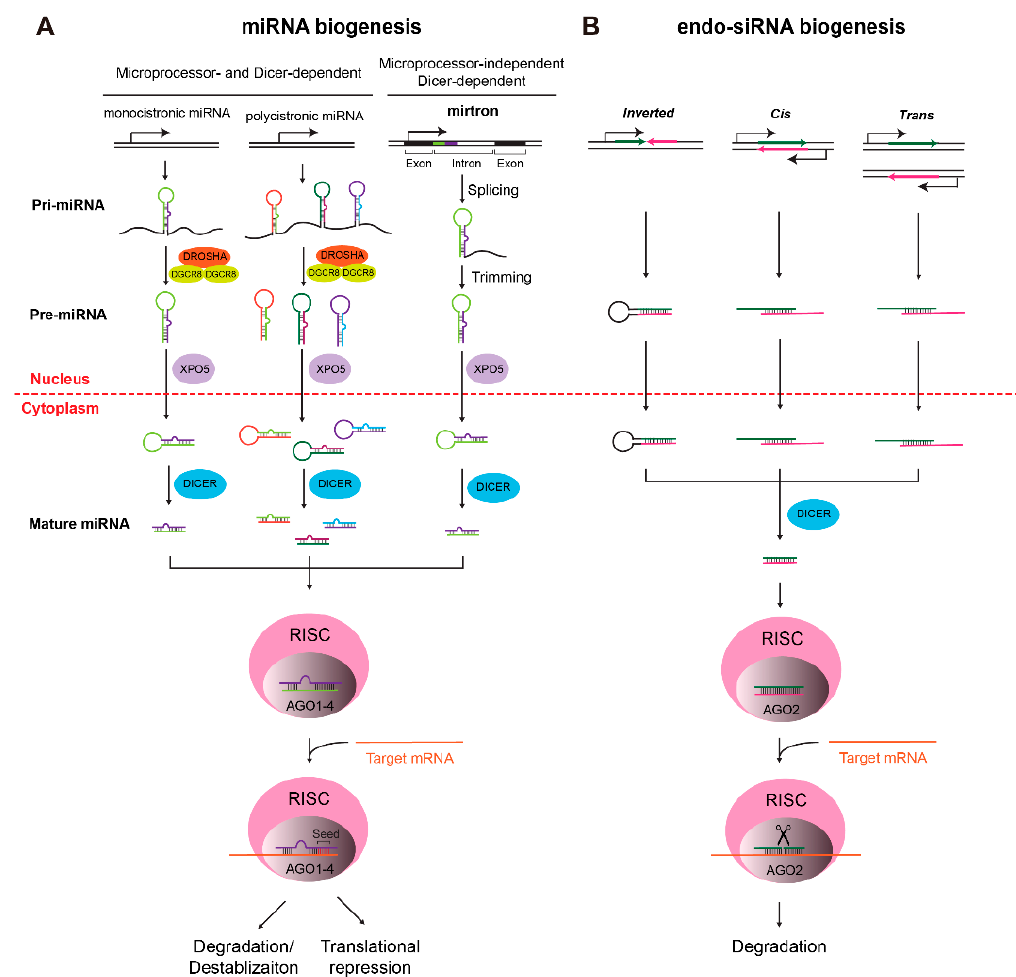
Figure 1: Dicer-dependent biogenesis of miRNAs ( A ) and endo-siRNAs ( B ). ( A ) Biogenesis of miRNAs can be microprocessor- and DICER-dependent (monocistronic and polycistronic miRNAs), or microprocessor-independent and DICER-dependent (mirtrons), with very few exceptions. For the former, monocistronic and polycistronic miRNAs are transcribed by RNA polymerase II as primary miRNAs (pri-miRNAs), which are processed by the microprocessor complex (DROSHA and DGCR8) and exported to the cytoplasm as precursor miRNAs (pre-miRNAs) for the further processing by DICER. Mirtrons, in contrast, are located in the intron and are generated by splicing and trimming that do not need the microprocessor complex to form pre-miRNAs. In both cases, pre-miRNAs need DICER for forming short mature miRNA duplexes. One strand of the duplex is then loaded onto the RNA-interference complex (RISC), where the miRNA recognizes its target mRNA through imperfect base pairing, especially the complementation between the short “seed” sequence of the miRNA and its mRNA targets, performing post-transcriptional silencing on target mRNAs through degradation or translational repression. ( B ) The biogenesis of endo-siRNAs starts with the formation of duplexes from one or two transcripts with complementary sequences. Duplexes are exported to the cytoplasm and processed by DICER as well. Different from miRNAs, endo-siRNAs duplex with their target mRNAs with a higher degree of complementation, inducing the splicer activity of Ago2 for the cleavage of mRNAs, leading to its degradation. Please note that miRNA RISC can be formed with Ago1–4, while the RISC for endo-siRNAs contains Ago2.